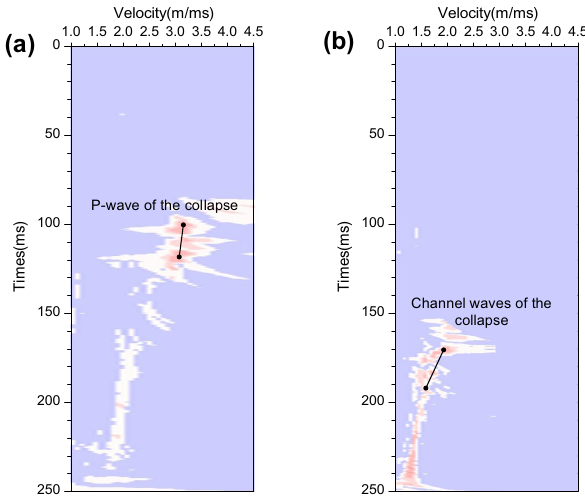
Fig. 11 Velocity spectra of No. 21 CSP gathers: a P -wave CSP gather, b Channel wave CSP gather